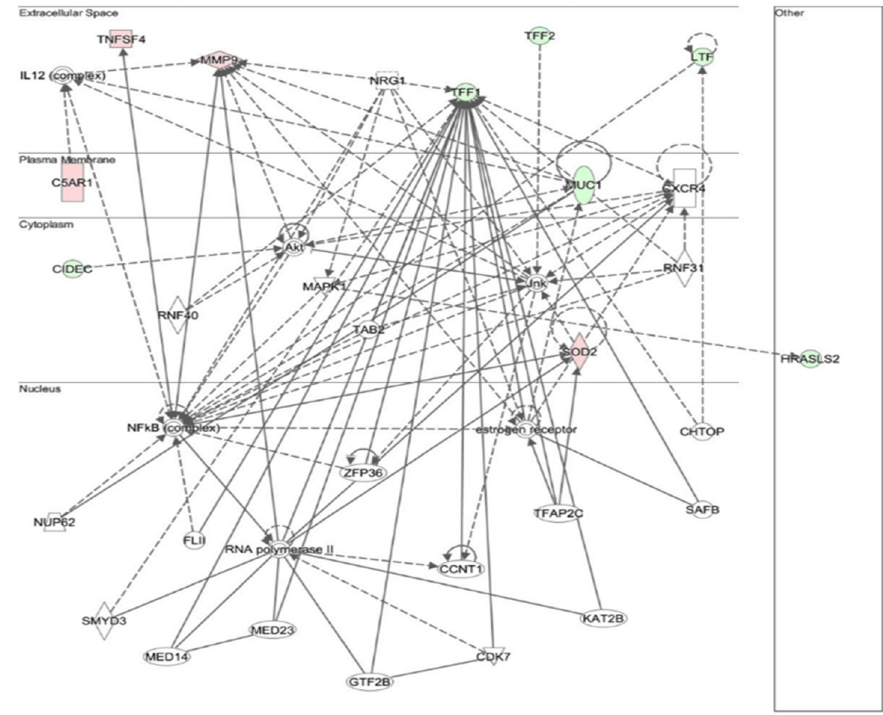
Figure 3. Network of functional gene expression, cellular growth and proliferation, and organismal injury and abnormalities related to gastric cancer vs. chronic atrophic gastritis. Colors: red, genes overexpression; green, gene subexpression. The intensity of the color indicates the degree of over- or subexpression. Encoding form: rectangle—nuclear receptor ligand-dependent; oval—transcription regulator; rhombus—enzyme; circle—other.